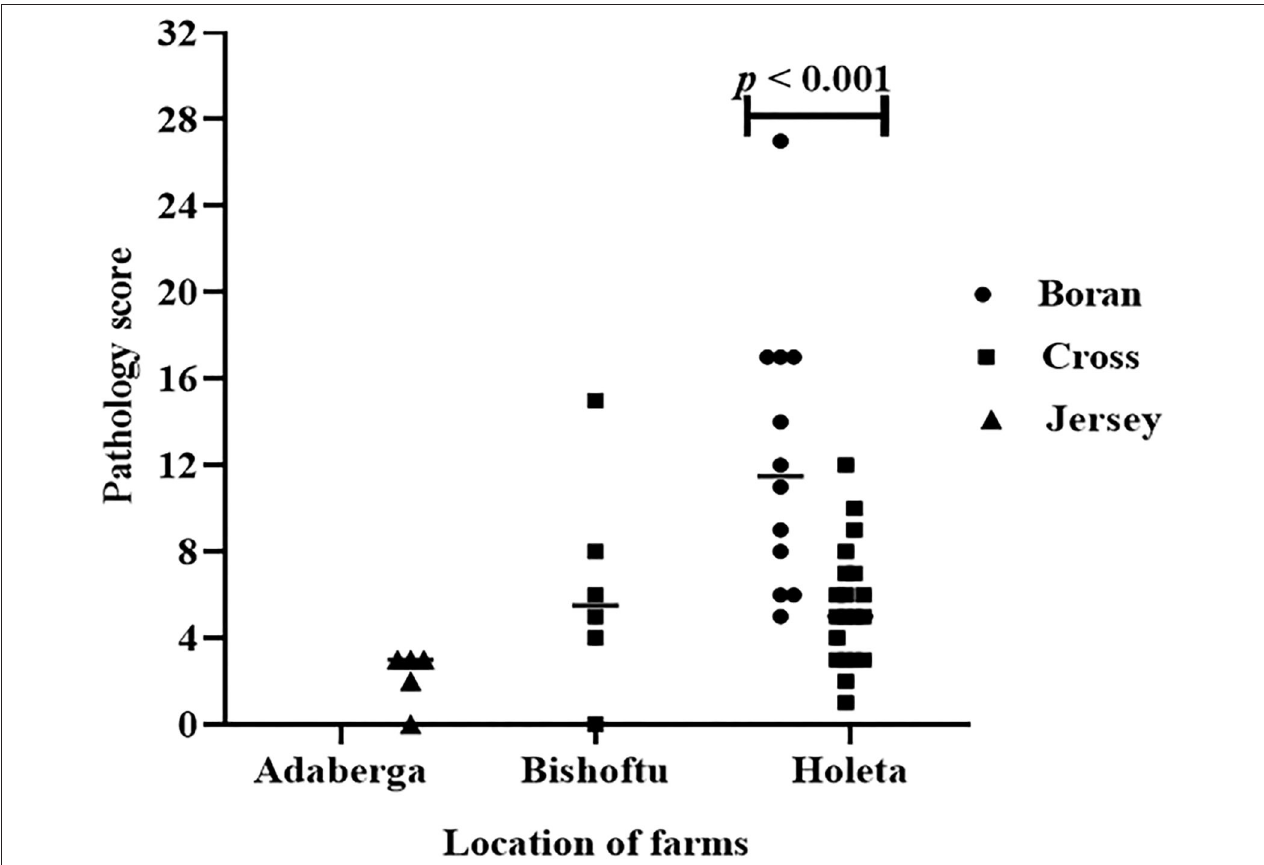
FIGURE 5 | Pathology score in the three breeds in three study farms. The difference in pathology score between the Boran and cross breeds was significant ( U = 33.5; p < 0.01) at farm located at Holeta. However, comparison of pathology between the breeds was not possible at the farms located at the Adaberga and Bishoftu as the positive animals in these farms belong to a single breed; Jersey at Adaberga and cross at Bishoftu.